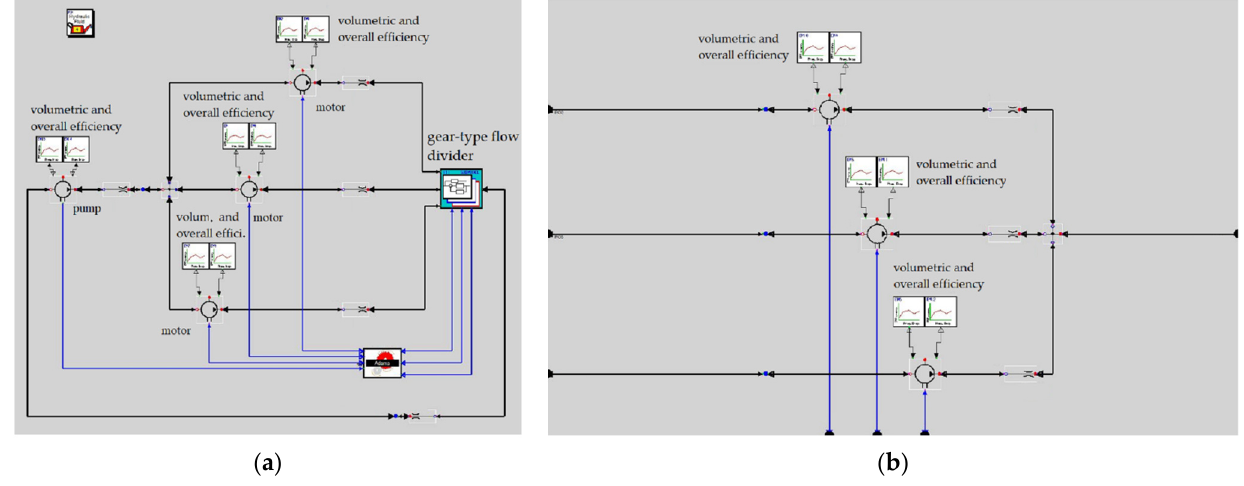
Figure 9. Model of the hydrostatic drivetrain with a gear-type flow divider ( a ) and the model of the gear divider ( b ).